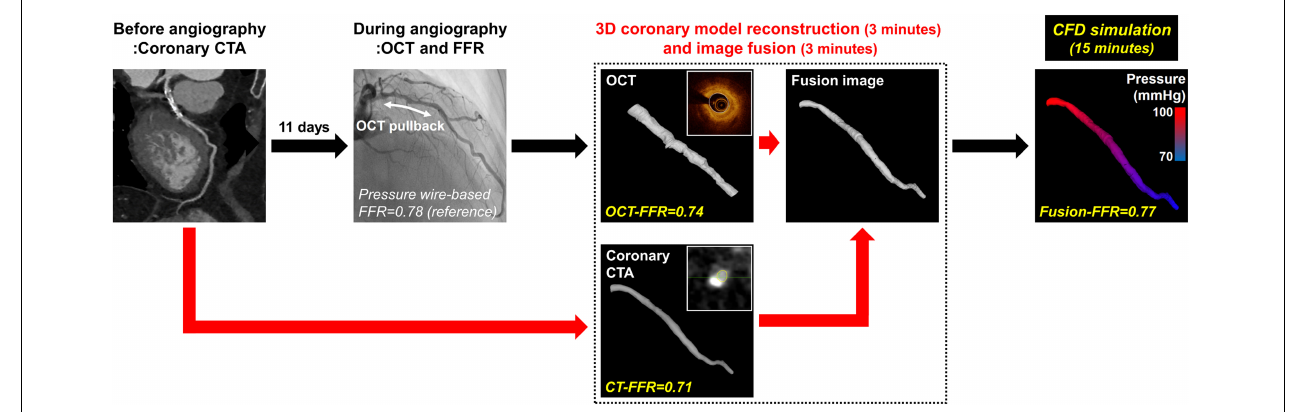
FIGURE 1 | Overview of estimating CFD-based computational FFR from coronary CTA-OCT fusion images in patients with intermediate coronary stenosis. The current study evaluated a novel approach to estimate CFD-based computational FFR from coronary CTA-OCT fusion images in patients with intermediate coronary stenosis in the left anterior descending artery. CFD, computational fluid dynamics; CTA, computed tomography angiography; CT-FFR, computational FFR from coronary CTA; FFR, fractional flow reserve; Fusion-FFR, computational FFR from coronary CTA-OCT fusion images; OCT, optical coherence tomography; OCT-FFR, computational FFR from OCT.